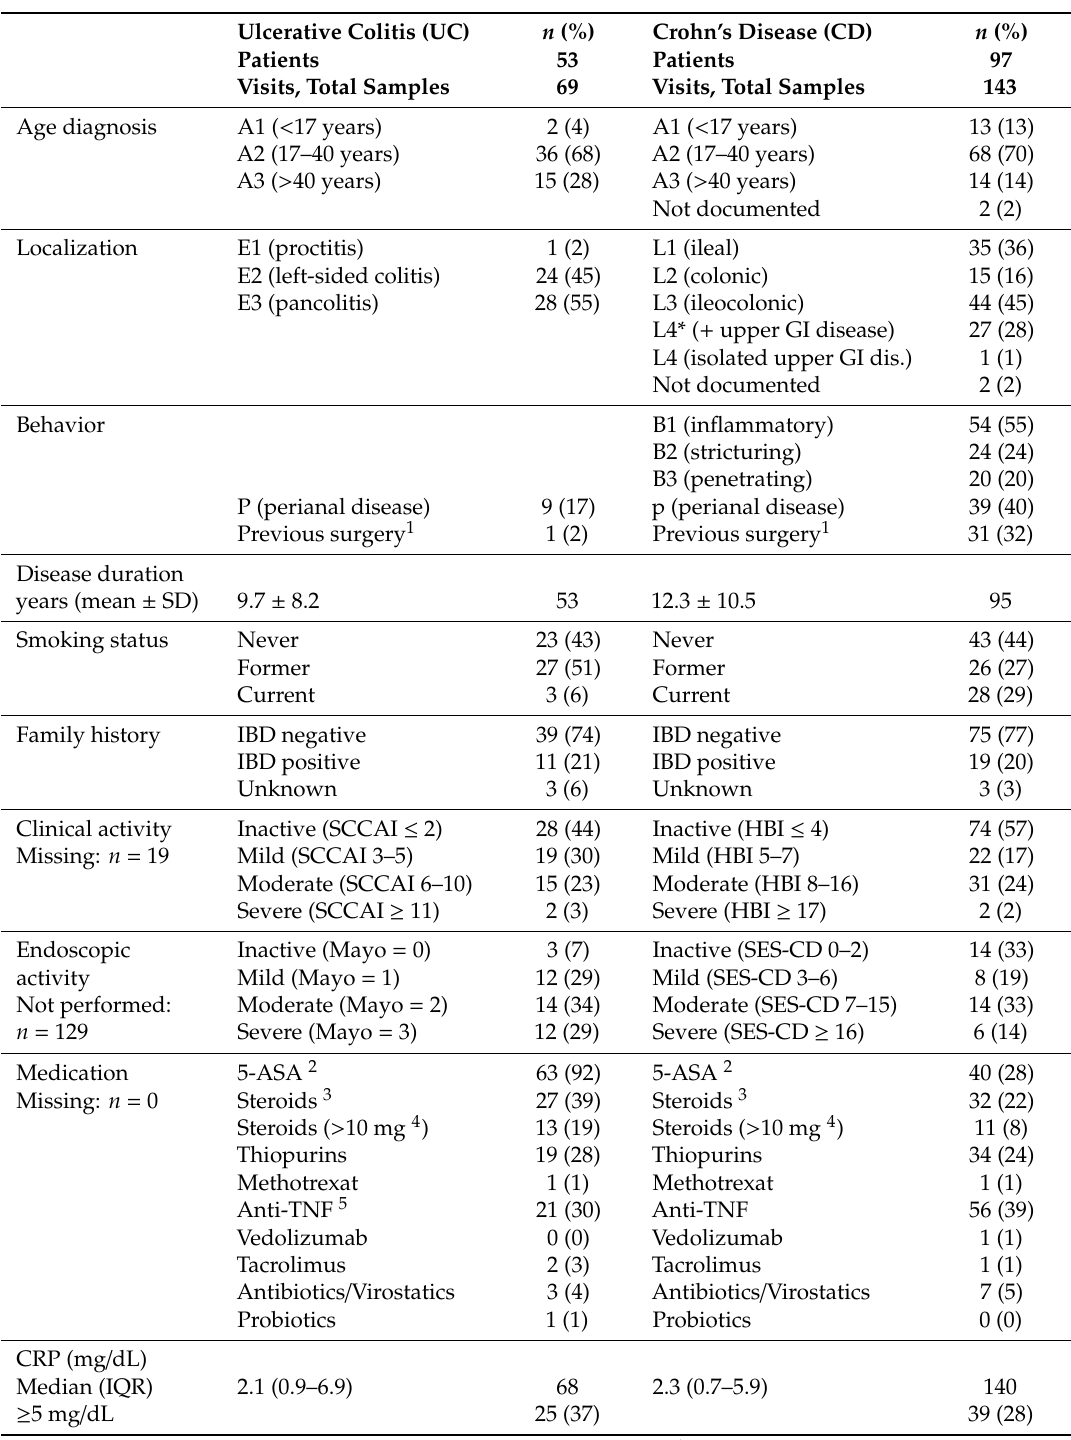
Table 2. Detailed characteristics of patients with inflammatory bowel disease